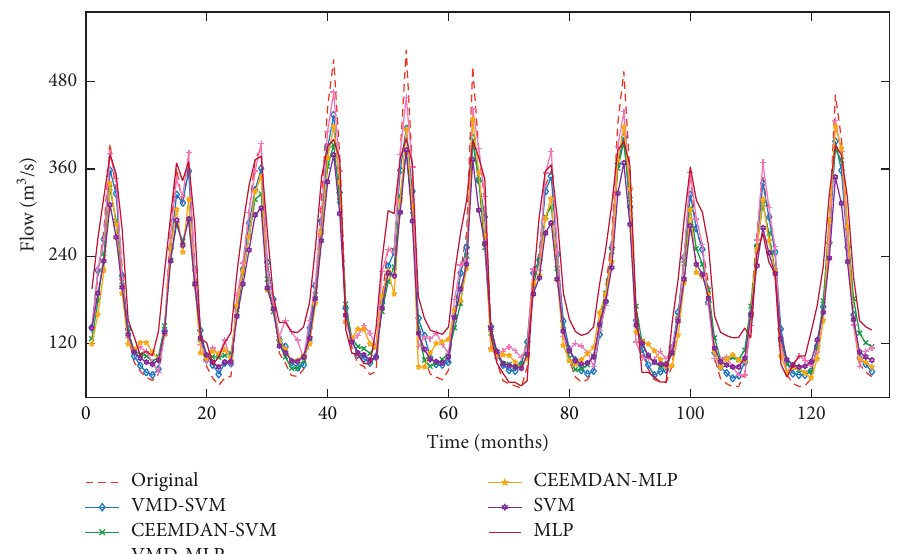
Figure 11: Observed and predicted runoff during the model testing period using VMD-SVM, CEEMDAN-SVM, VMD-MLP, and CEEMDAN-MLP models.